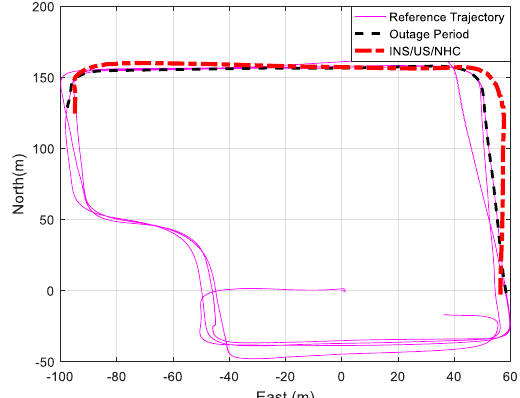
Figure 20. First trajectory INS/Ultrasonic velocity and heading change updates/NHC navigation solution for 60 seconds GNSS signal outage